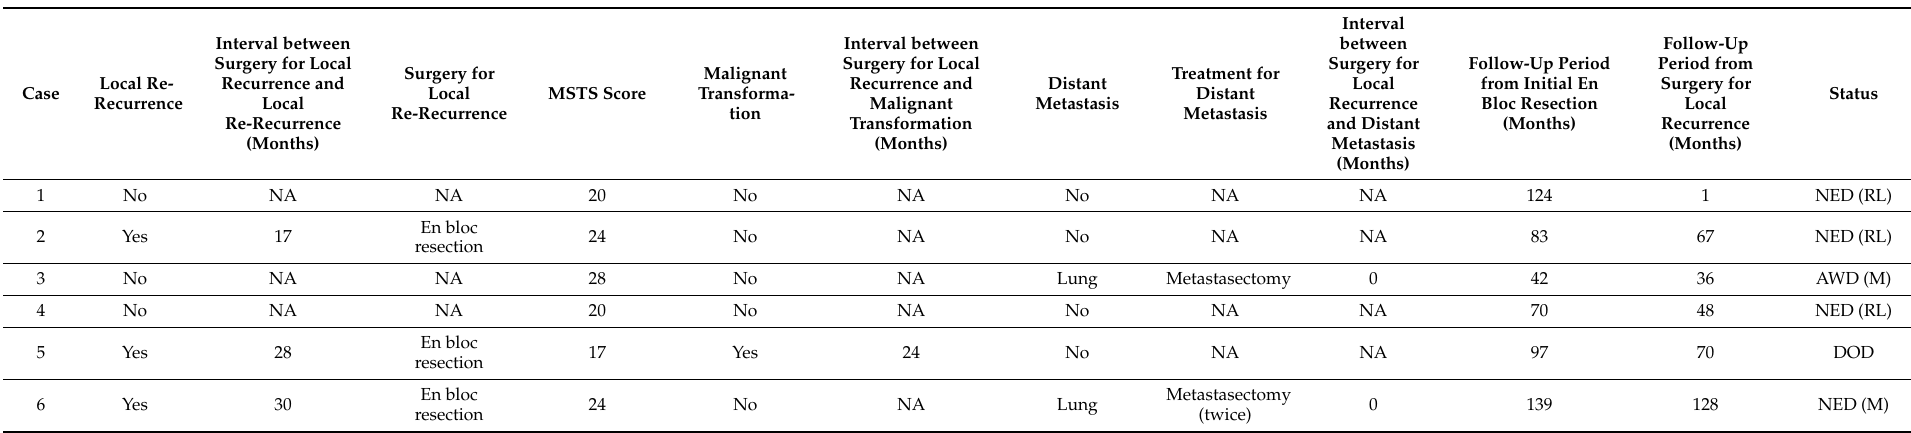
Table 4. Details of 29 patients with GCTB of the extremities who experienced local recurrence after en bloc